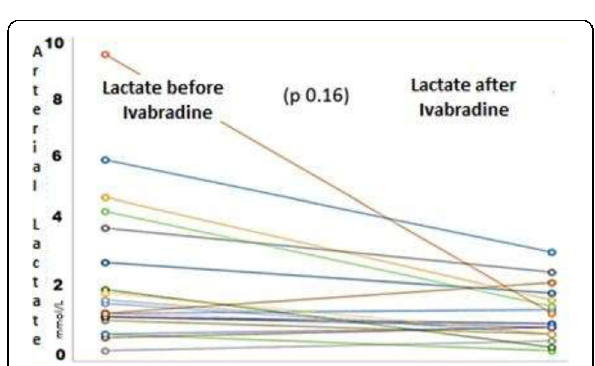
Fig. 2 (abstract 0336). Arterial lactate levels before and after Ivabradine